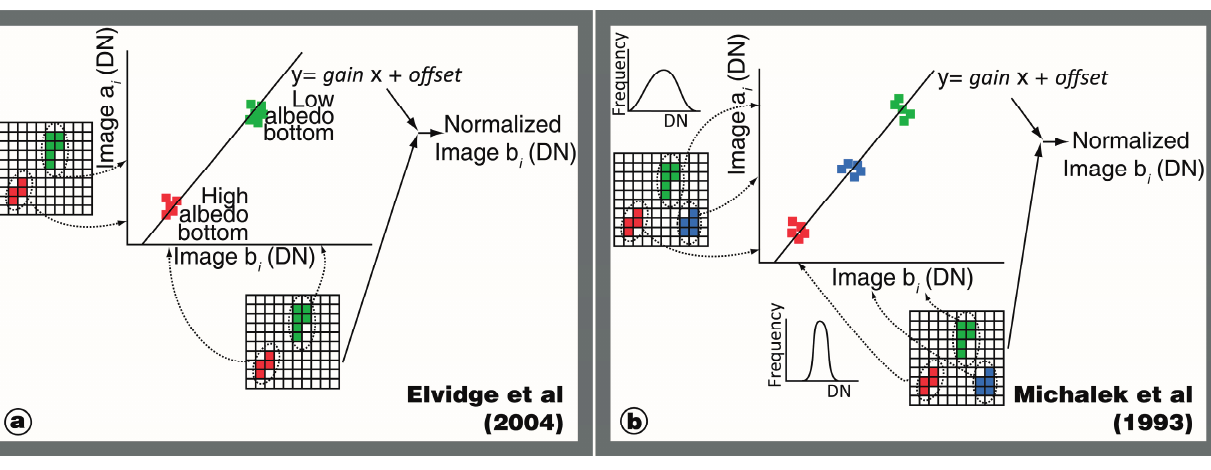
Figure 5. ( a ) Diagram to obtain of gain and offset values to normalized image as function of a previous one, according to Elvidge et al. [10] approach; ( b ) Diagram to obtain of gain and offset values to normalize an image as function of a previous one, according to Michalek et al. [82]